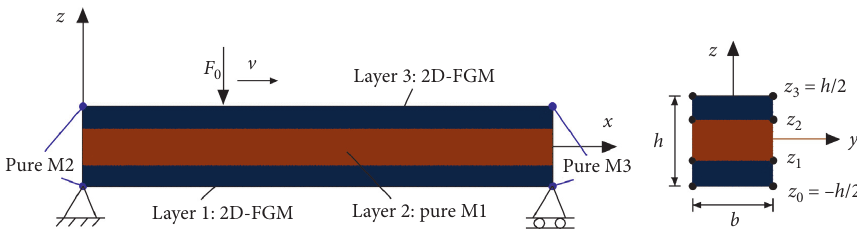
Figure 1: A simply supported BFGSW beam under a moving